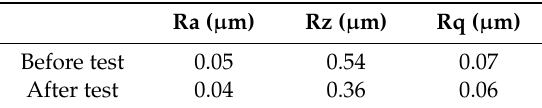
Table 1. Roughness parameters of rod surface.